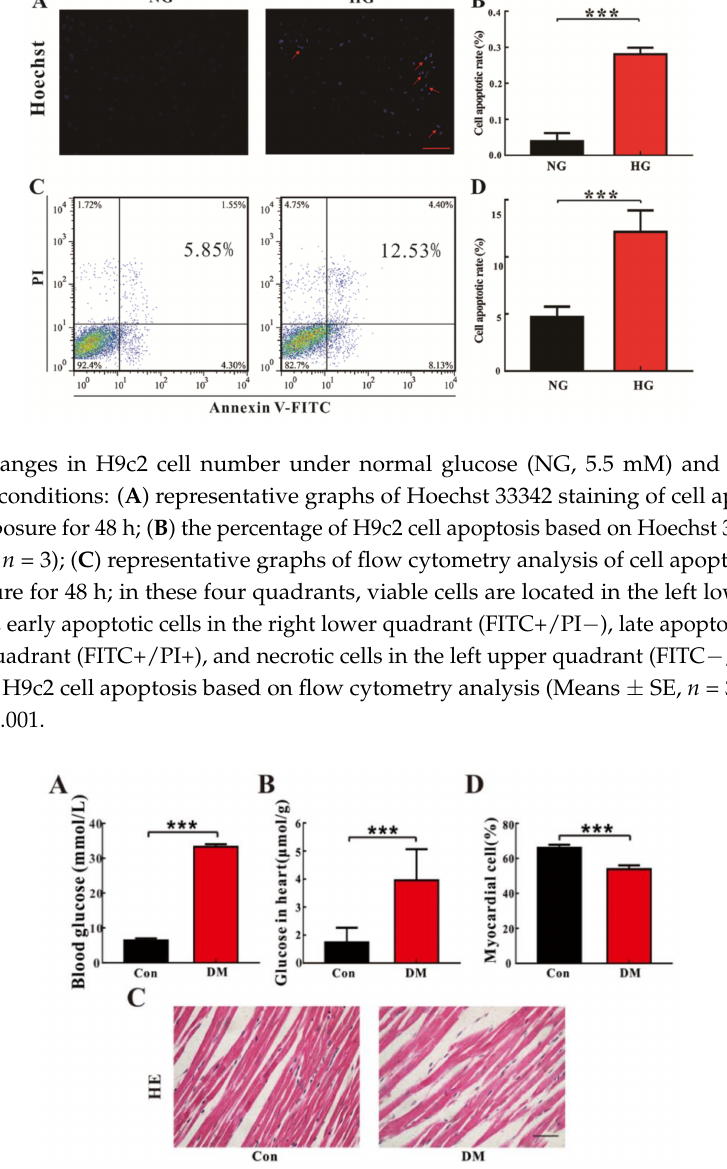
Figure 2. Changes in cardiomyocyte number in streptozotocin (STZ)-induced diabetic (DM) and normal control (Con) rats: the levels of glucose in the serum ( A ) and the heart ( B ) of DM and Con rats (Means ± SE, n = 6); ( C ) representative graphs of Haematoxylin-Eosin (HE) staining of heart tissues in Con and DM rats; ( D ) percentage of normal myocardial cell calculated from the HE staining (Means ± SE, n = 6); significant level: *** p <